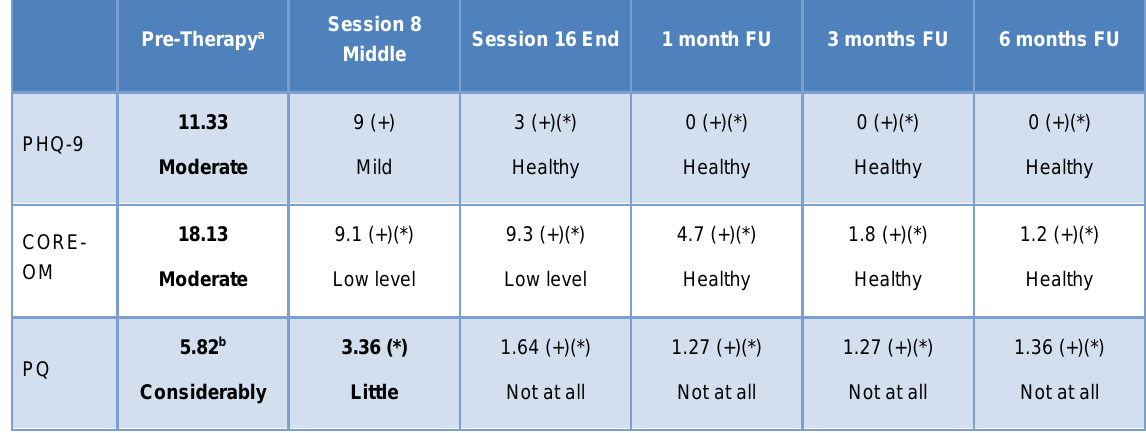
Table 1: Giorgio’s Quantitative Outcome